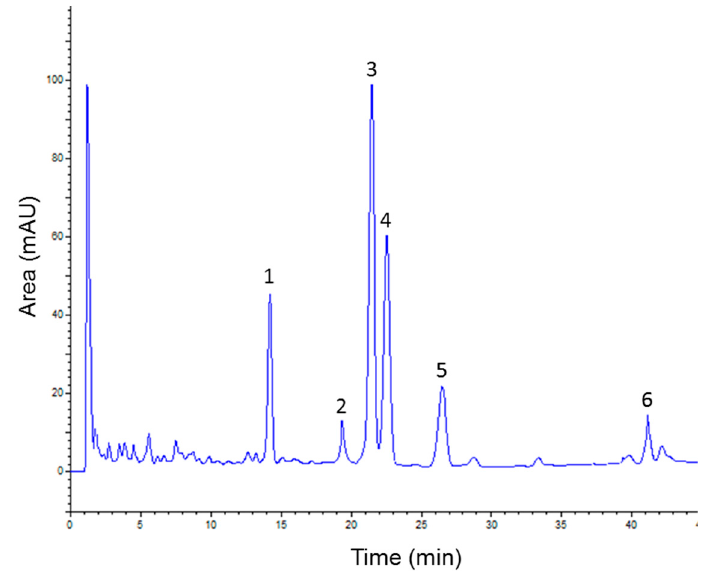
Figure 1. HPLC-UV profile of aqueous extract from Aloysia triphylla leaves with detection at 280 nm. Peaks: 1, luteolin-7- O -diglucuronide; 2, apigenin-7- O -diglucuronide; 3, verbascoside; 4, diosmetin-7- O -diglucuronide; 5, isoverbascoside; and 6, apigenin-7- O -glucoside.